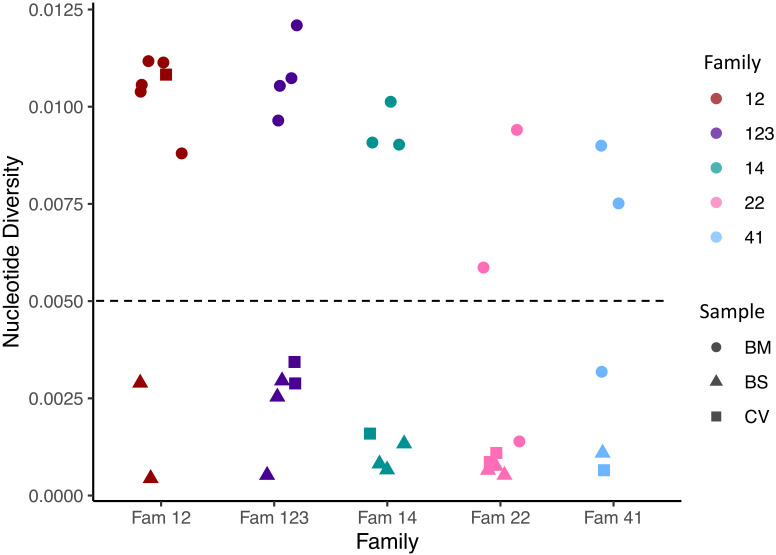
Within sample nucleotide diversity shown by family (colour) and sample type (symbol).BM, breast milk; CV, cervix; BS, baby blood spot. The figure shows that most cervical and blood spot samples are of low diversity, while most breast milk samples are of high diversity. Diversity of breast milk versus cervix; p=1.619e-07 versus baby blood spot; p=9.69e-6 (Mann–Whitney test).